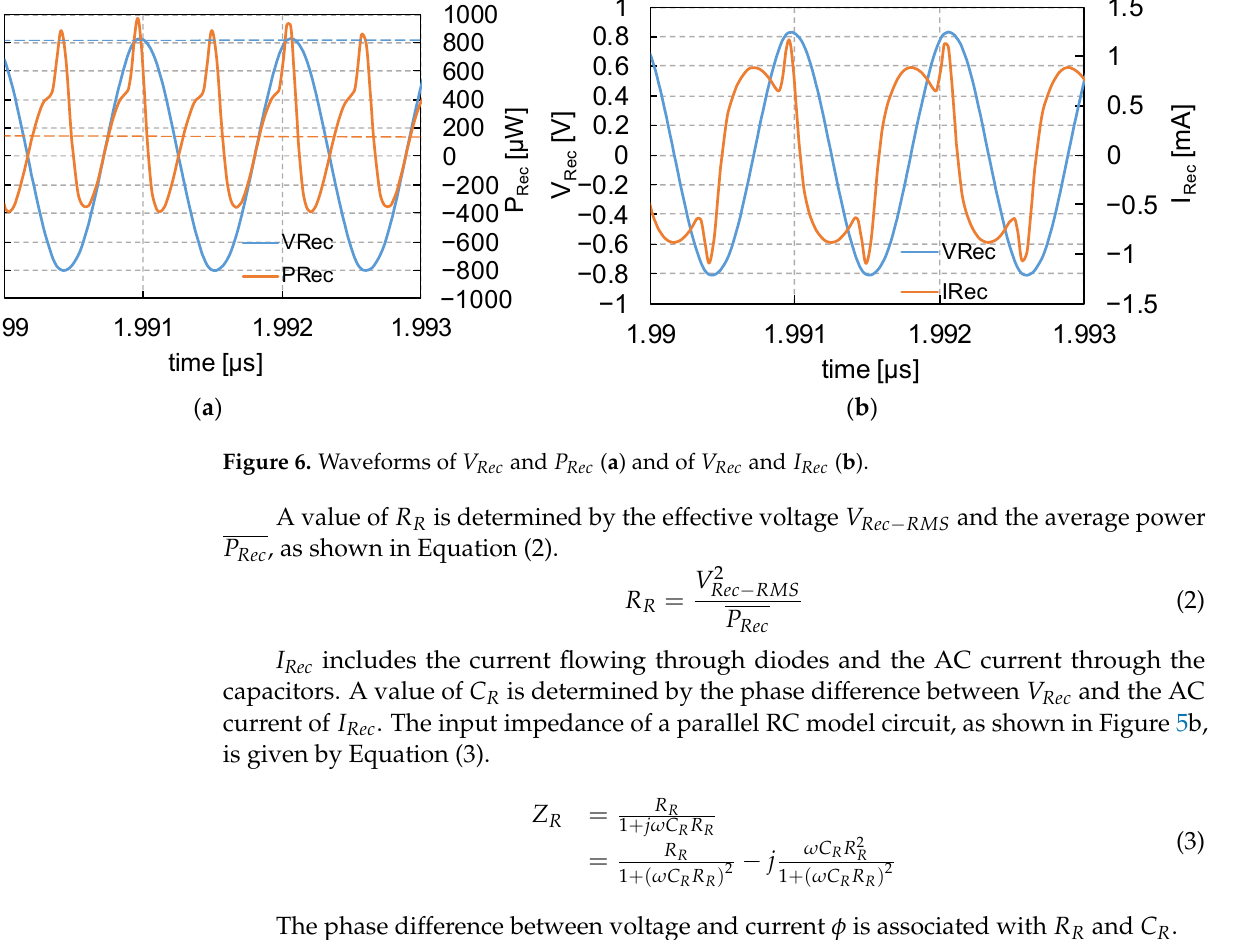
The phase difference between voltage and current  is associated with   and   .